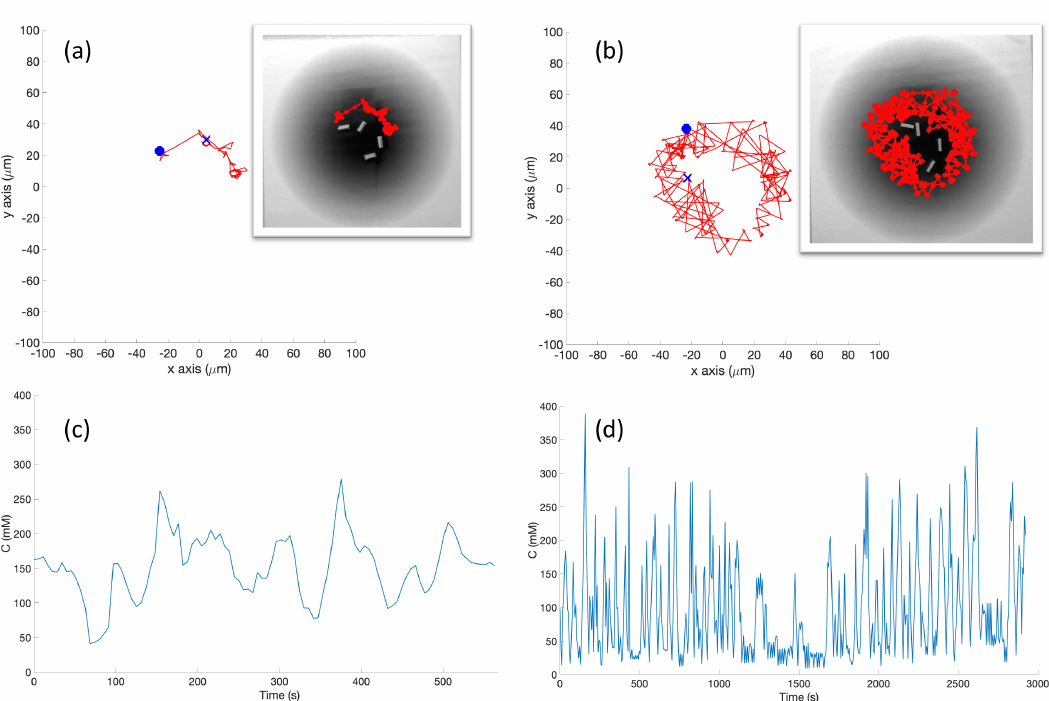
Figure 19. Case 10: With obstacles, in the single-effluent environment, typical trajectories of the e-puck robot running ( a ) the basic chemotaxis controller, and ( b ) the RapidCell chemotaxis controller. In each trajectory, the initial position is shown as a blue circle and the terminal position is shown as a blue “X”. Positions corresponding to concentrations less than 1m M are shown in dashed green, otherwise shown in red. The recorded concentrations associated with each scheme are shown in ( c , d )